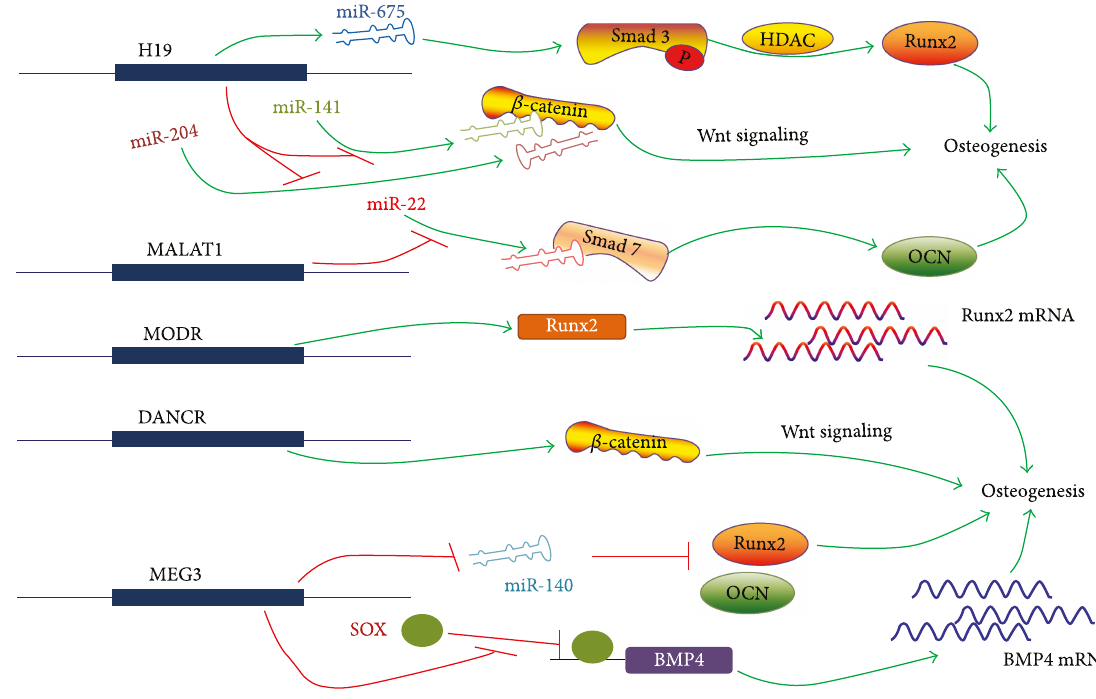
Figure 2: lncRNAs that inhibit osteogenic di ff